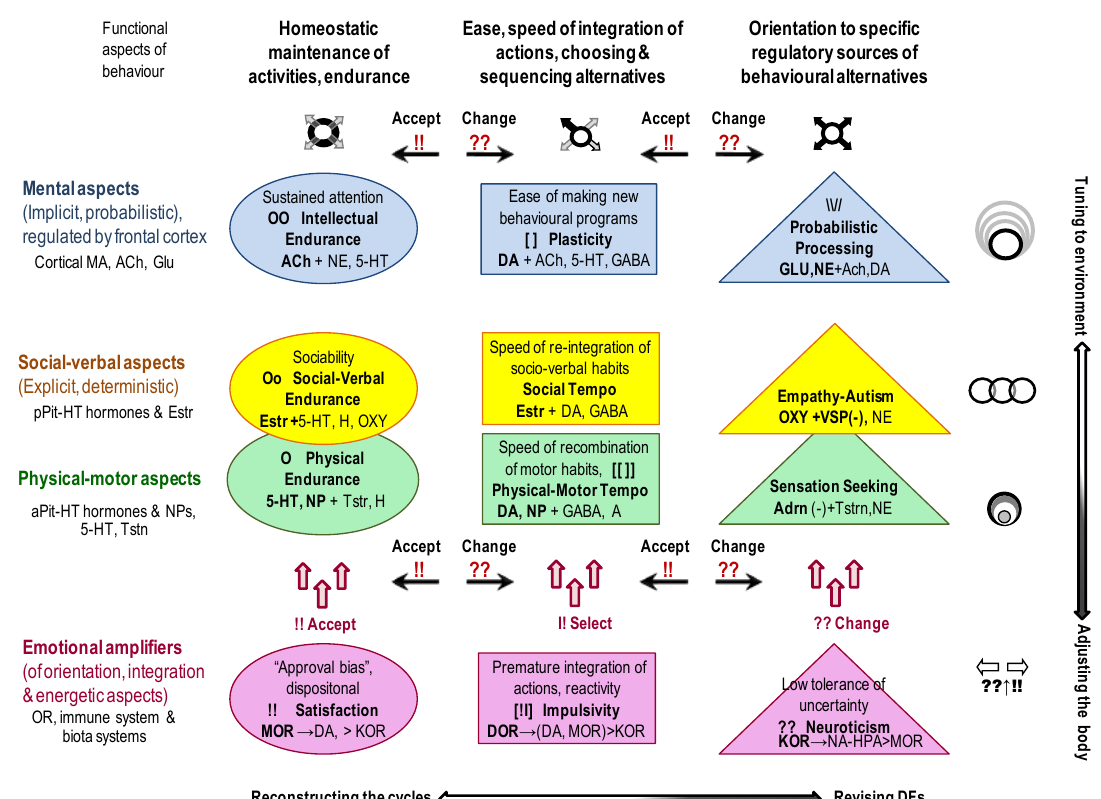
Figure 3. Neurochemical framework Functional Ensemble of Temperament (FET) summarizing the action of neurochemical systems in the regulation of 12 universal aspects of action construction. Red “?” and “!!” signs symbolize emotional amplifiers based on opioid receptor systems, as described in our earlier reviews. When selected DFs do not work, a further search for alternatives is increased (“?”), and if it does—the chosen alternatives are approved (“!!”). The “?” system that generates the release of the catecholamines (DA in familiar elements of behaviour and NE in novelty), as well as the HPA axis arousal in rough emotional response, is represented by KOR, some microbiota and cytokines systems. The “!!” system that generates the release of DA and suppresses the HPA axis activation is based on the action of MOR (in the ventral striatum), DOR (in dorsal striatum) and some microbiota. Note: ACh: acetylcholine; NE: noradrenaline; 5-HT: serotonin; DA: dopamine; OXY: oxytocin, VSP: vasopressin, Tstr: testosterone; Adr: adrenalin (and its deficient cycles); GC—glucocorticoids (including cortisol dysregula- tion); ORE: orexins; NP: neuropeptides; Glu—glutamate; GG—Gamma-Aminobutyric Acid and Glu; (M/D/K)OR: (mu/delta/kappa) opioid receptor systems; ANS—autonomic nervous